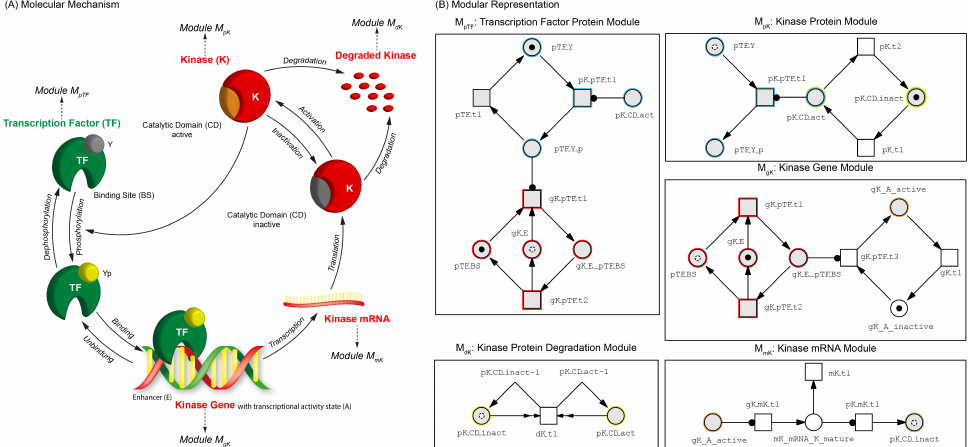
Figure 3: (A) Molecular mechanism: Active kinase (K) phosphorylates its transcription factor (TF), the phosphorylated TF binds to the K gene, which starts the transcription, followed by protein translation of K. (B) Modular representation by PNs: Two protein modules for the TF and K, one gene, mRNA and protein degradation module for K according to the molecular mechanism in (A). Nodes highlighted in the same colour define a shared interface network. Modules share their tokens after model composition and thus, the dotted tokens appear on shared places enabling the execution of inter-